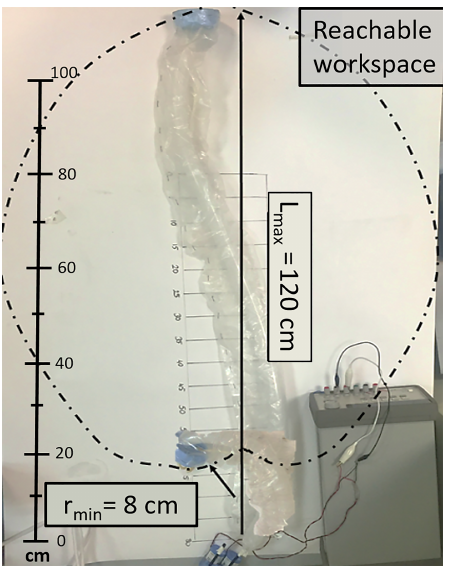
Figure 10. Reachable workspace, maximum reach and minimum radius of curvature of the robot. Side-to-side width of the reachable workspace is about